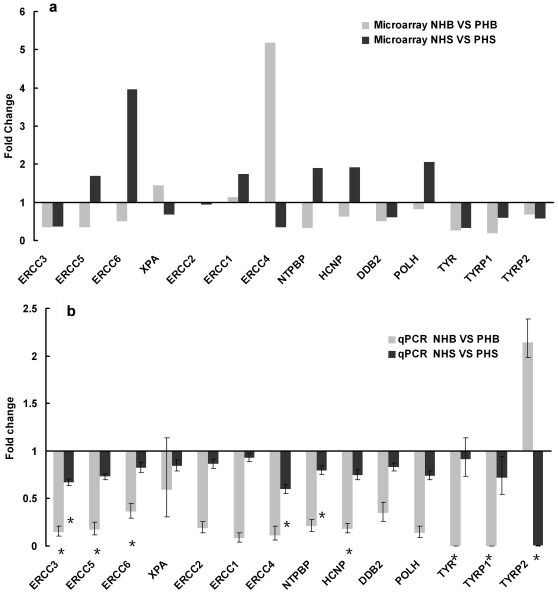
Quantitative PCR analysis of selected NER genes.Quantitative expression of 11 genes identified from microarray data, with known functional significance related to NER, was determined (a). We also reconfirmed differential gene expression of melanocyte markers (tyrosinase, tyrosinase related protein 1) as validation (b). Trends for upregulation or down-regulation were largely consistent with microarray data.